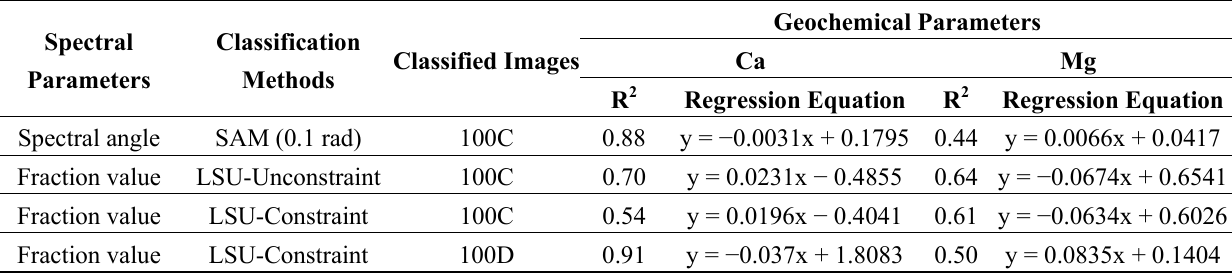
Table 3. Summary of the linear regression results from SAM and LSU classifications of images on the major geochemical elements (Ca and Mg) in carbonate samples. Note that the average spectral classification results were acquired on the same regions of interest (ROIs) of the PXRF spot